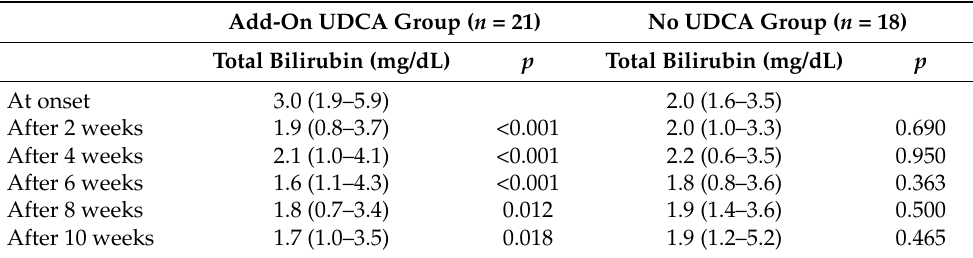
Table 5. Changes in total bilirubin in patients with hyperbilirubinemia ≥ grade 2 treated with and without add-on ursodeoxycholic acid.